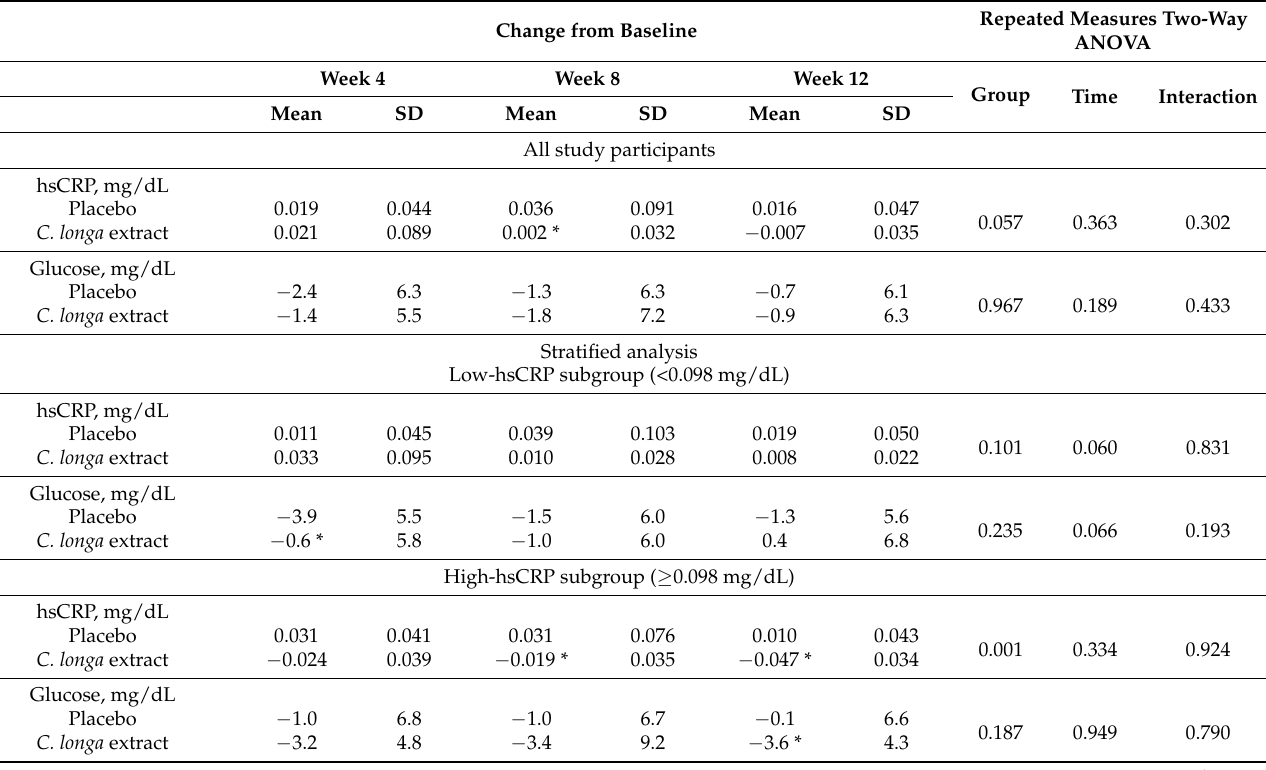
Table 5. Effect of C. longa extract on serum hsCRP and glucose levels stratified by baseline hsCRP levels in study 2 1 . Change from Baseline Week 4 Week 8 Week 12 Mean SD Mean SD Mean SD All study